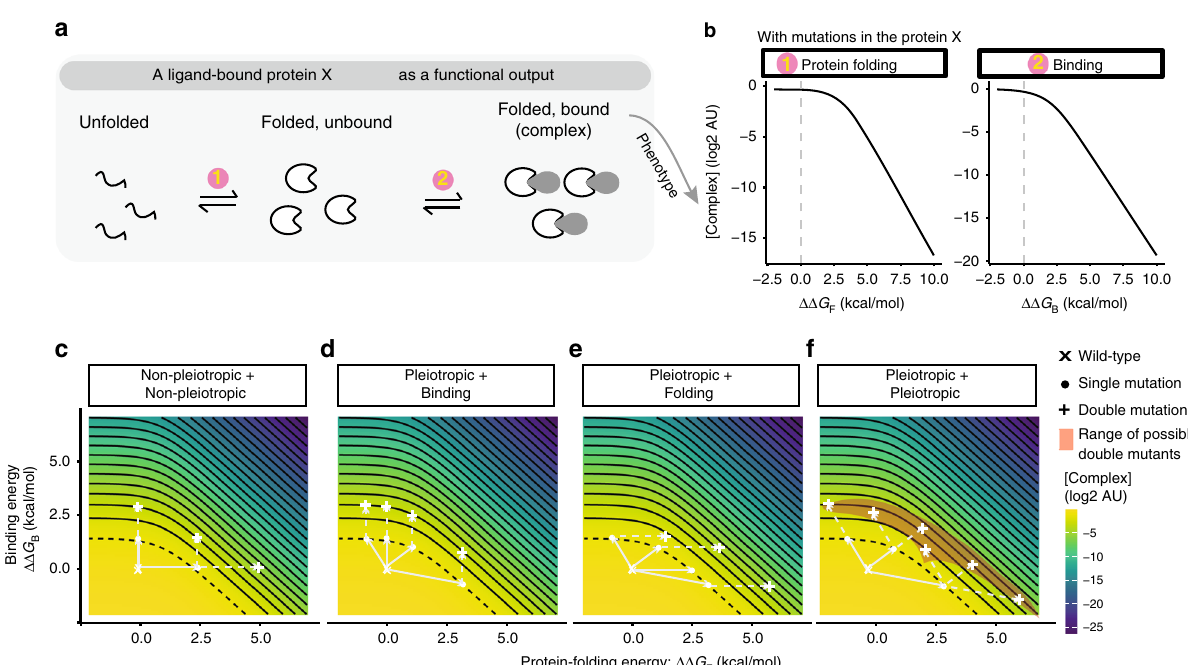
Fig. 6 Biophysical ambiguity in a protein – protein interaction system. a Statistical thermodynamic model of a protein binding to a ligand. The protein X exists in three states: unfolded, folded, and folded and bound to the ligand. The partitioning of these molecules depends on the Gibbs free-energy differences between states. b Mutations result in additive changes in the free energy of protein folding and binding, altering the concentration of the protein – ligand complex. c – f Free-energy-phenotype landscapes for mutations that affect the free energy of folding ( x -axis) and/or binding energy ( y -axis). Phenotypic isochores are drawn with an interval of 1 in log(2) scale. A continuous range of free-energy changes can underlie an observed phenotype (dashed isochore). Combining two mutations with the same effect can result in a range of double mutant phenotypes (red shaded areas in ( f )). Example double mutant outcomes are shown when neither ( c ), one ( d , e ) or both ( f ) mutations are pleiotropic. See also Supplementary Fig. 5. Source data are provided as a Source data fi